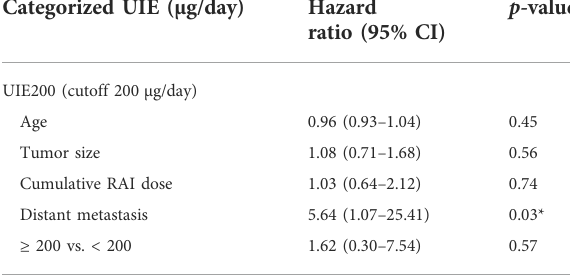
TABLE 3 Relative hazard ratios (HRs) and 95% con fi dence interval (CI) of progression for urinary iodine excretion (UIE) using the multivariate Cox proportional regression